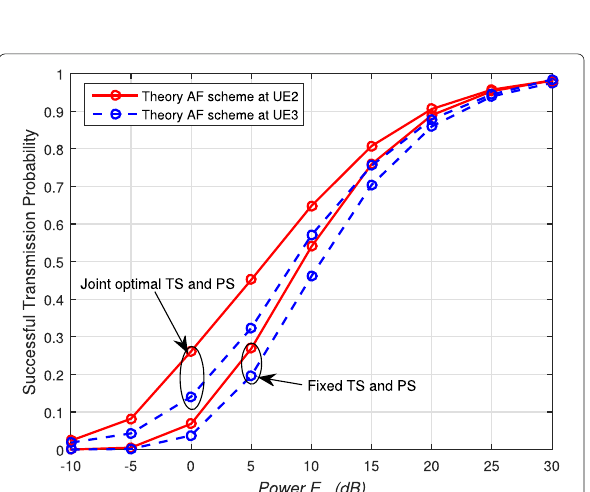
Fig. 14 STP versus E D (dB) in AF scheme